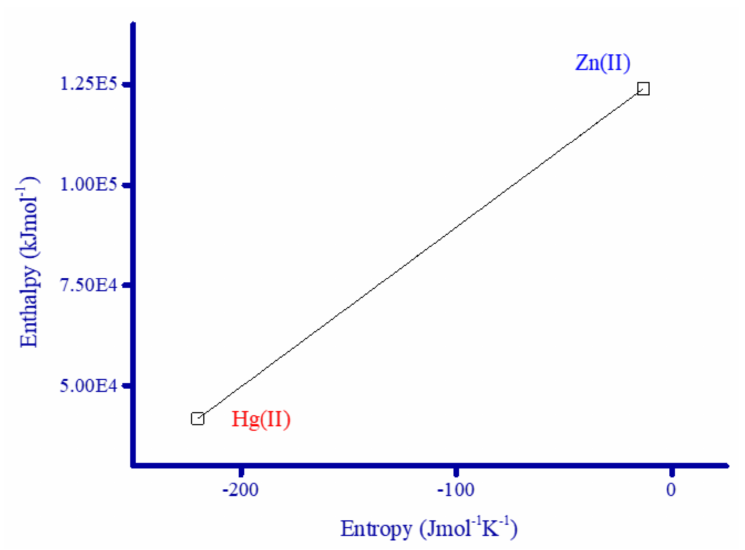
Figure 14. Linear correlation between the entropy and the enthalpy of Zn 2+ and Hg 2+